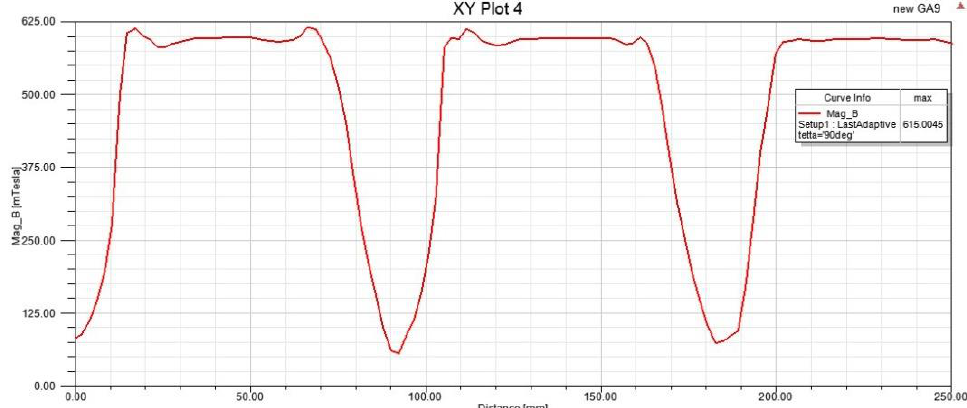
Figure 7. Magnetic flux density distribution of the air gap for average radius.